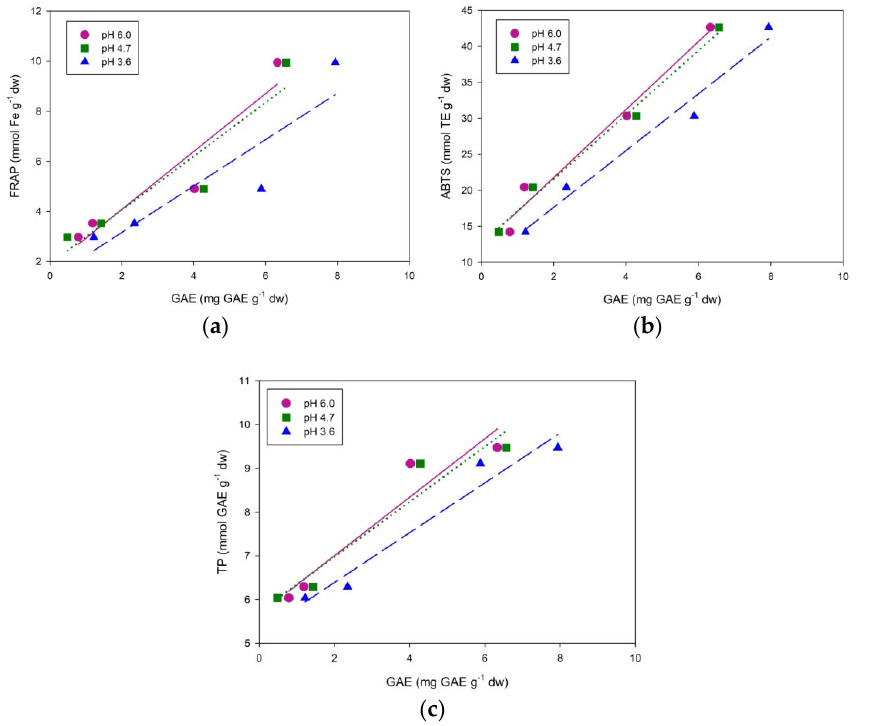
Figure 3. Correlation between cyclic voltammetry (pH 6.0, 4.7 and 3.6) and spectrophotometric results—statistical analysis: ( a ) FRAP ( b ) ABTS ( c ) TP.